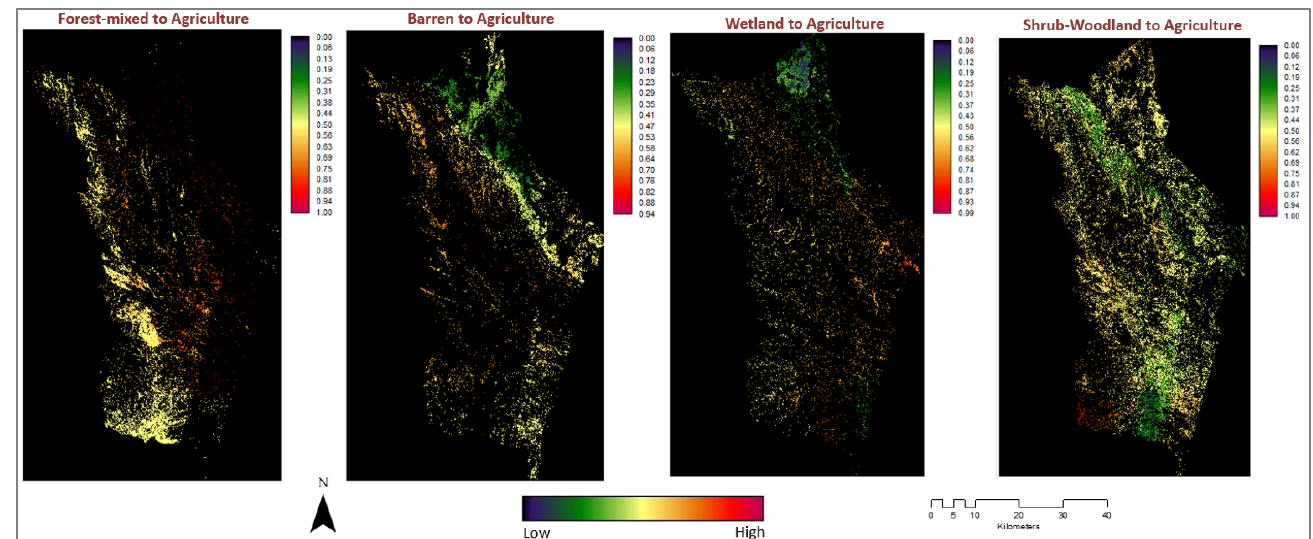
Figure 9. Land-Cover Transition Potentials (Probabilities): Ntcheu District.